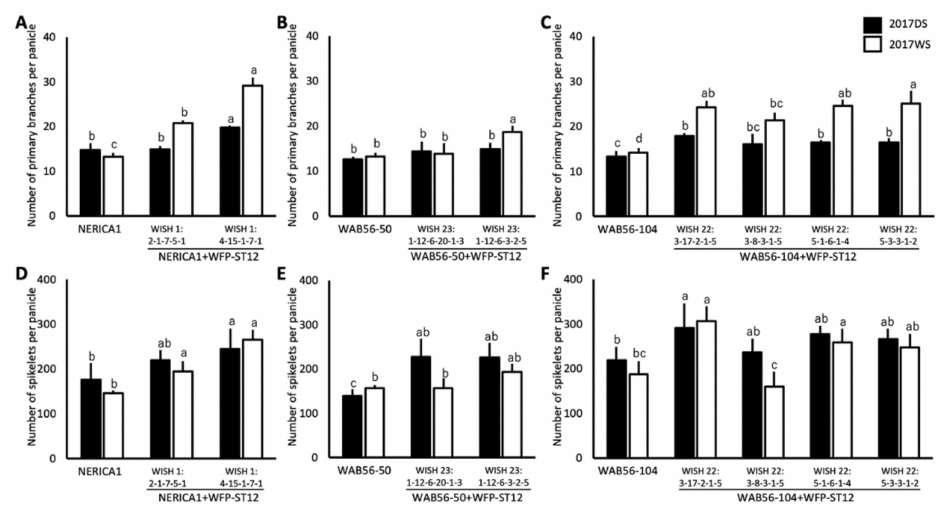
Figure 5. Number of primary branches per panicle ( A – C ) and numbers of spikelets per panicle ( D – F ) (mean ± SD) of WFP - ST12 introgression lines in the genetic backgrounds of NERICA1 ( A and D ), WAB56-50 ( B and E ), and WAB56-104 ( C and F ). Solid and white bars show the results in 2017DS and 2017WS, respectively. Different letters above the bar graphs indicate significant difference at p < 0.05.